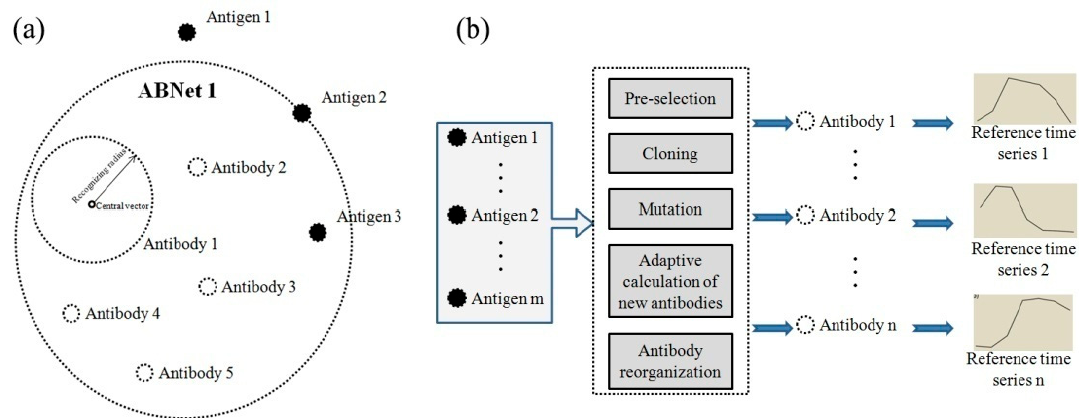
Figure 6. ABNet model and the procedure of generating reference time series. ( a ) ABNet model, ( b ) procedure of generating reference time series. ABNet, Antibody network.